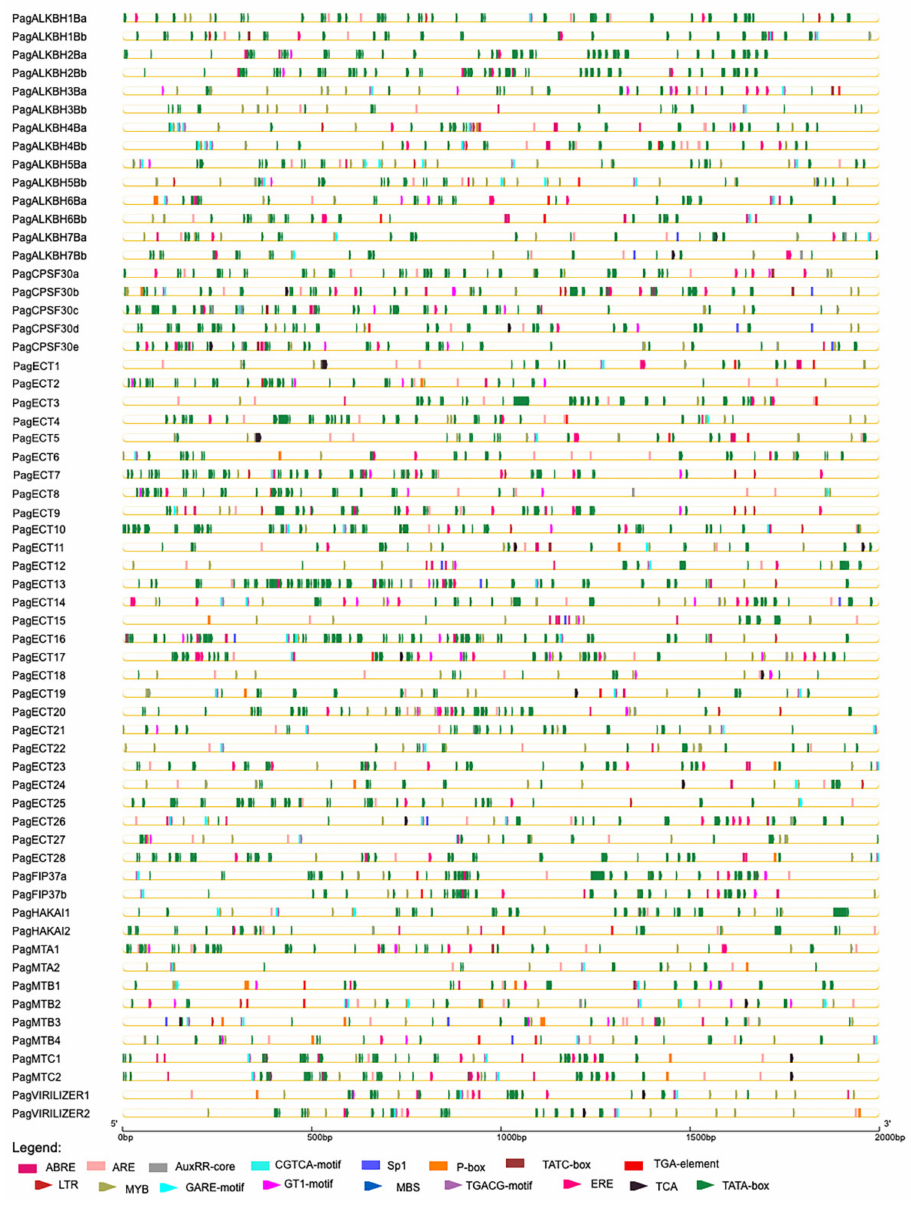
Figure 4. The cis -regulatory elements in the promoter of 61 m 6 A pathway genes. The cis -regulatory elements were represented bytriangle and rectangle in different